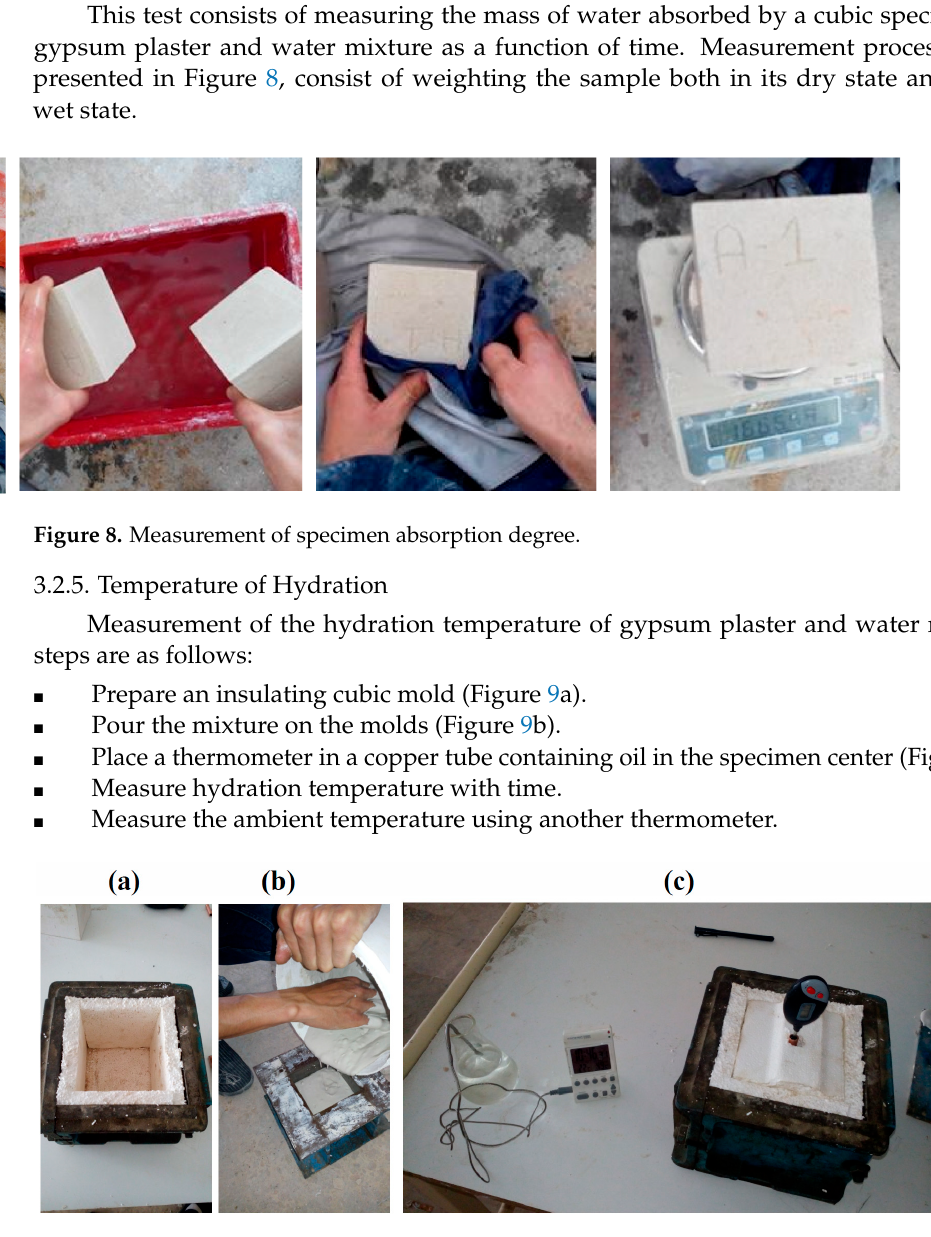
Figure 7. Density measurement process.